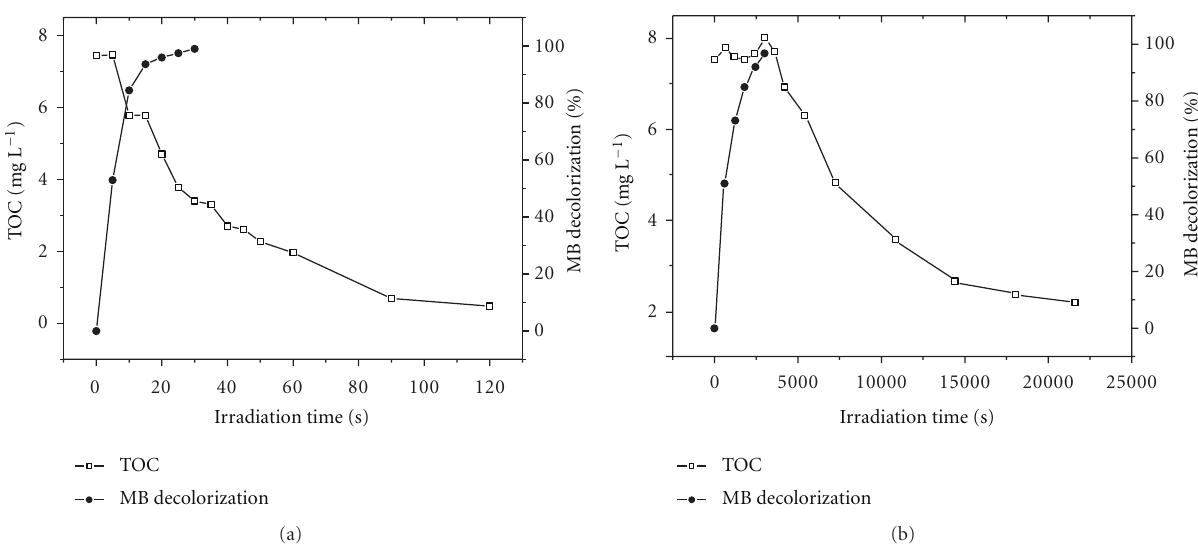
Figure 4: The TOC removal and decolorization e ffi ciencies versus irradiation time by (a) HUP and (b) LUP. (Experimental conditions: